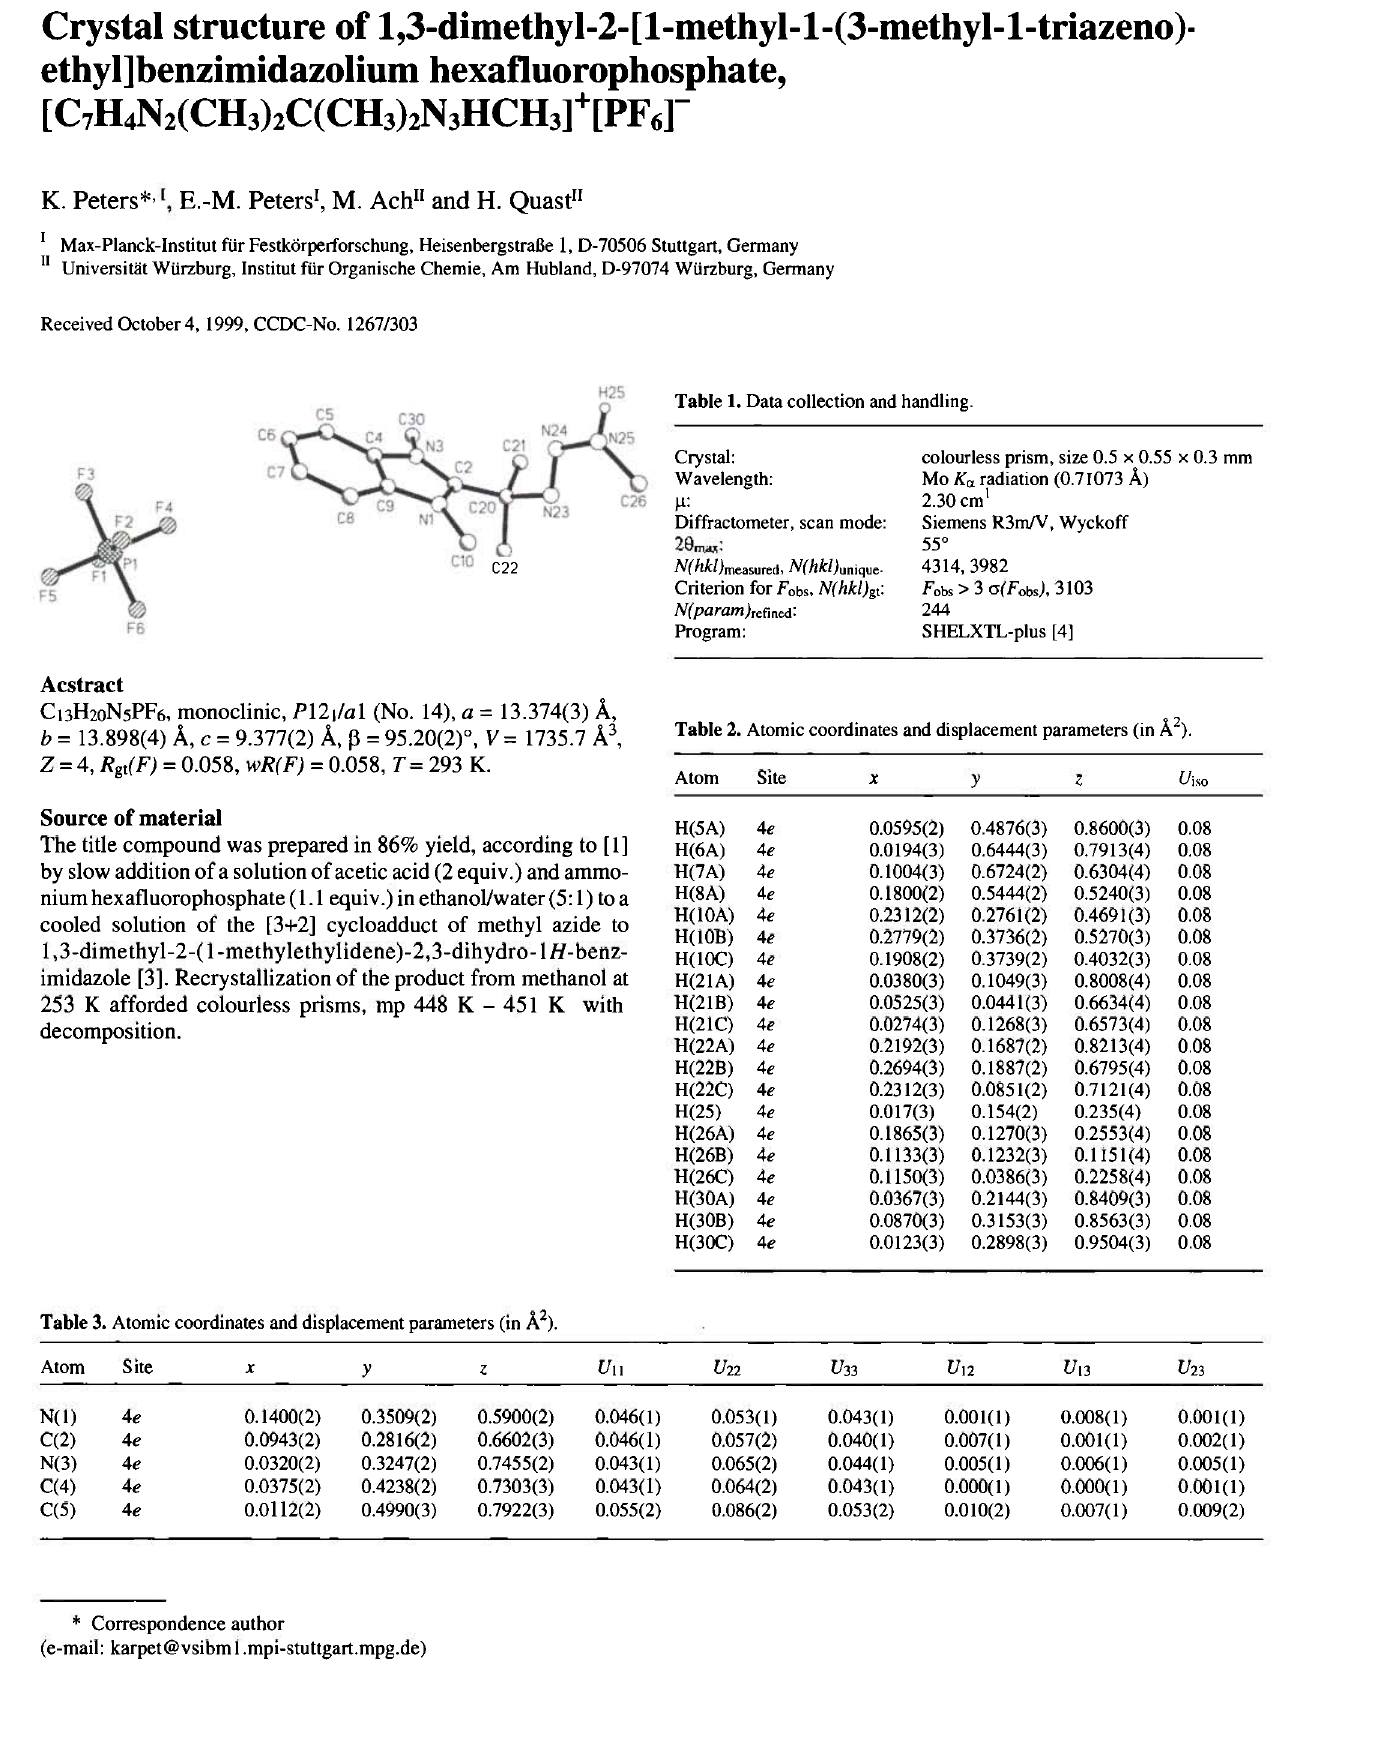
Table 1. Data collection and handling.